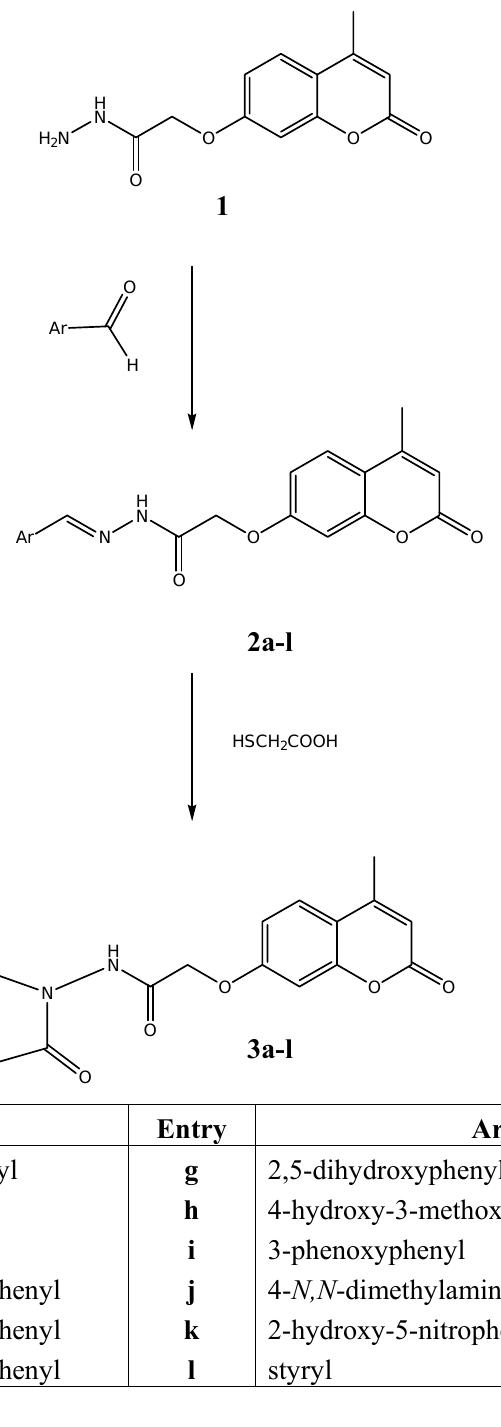
Scheme 1. Synthesis of 2,3-disubstituted-1,3-thiazolidine-4-ones 3a-l